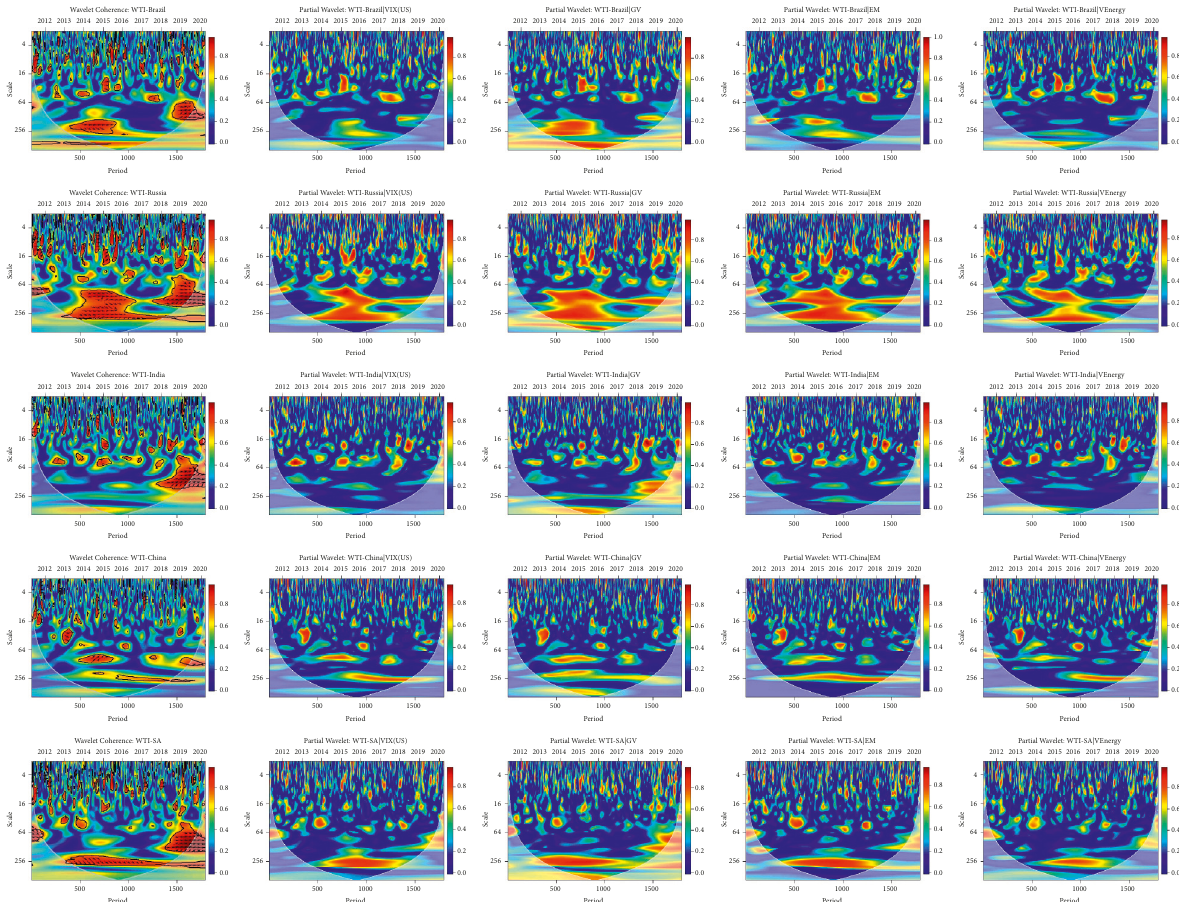
Figure 6: Comovements among WTI crude oil, BRICS, and volatility